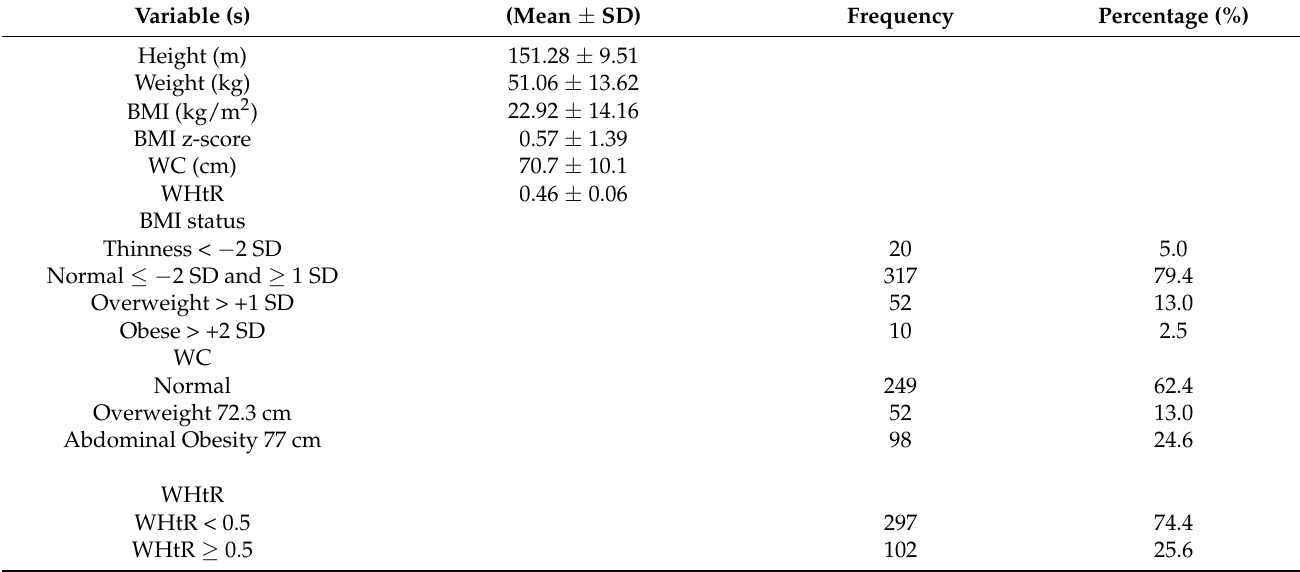
Table 2. Anthropometric characteristics of the respondents.